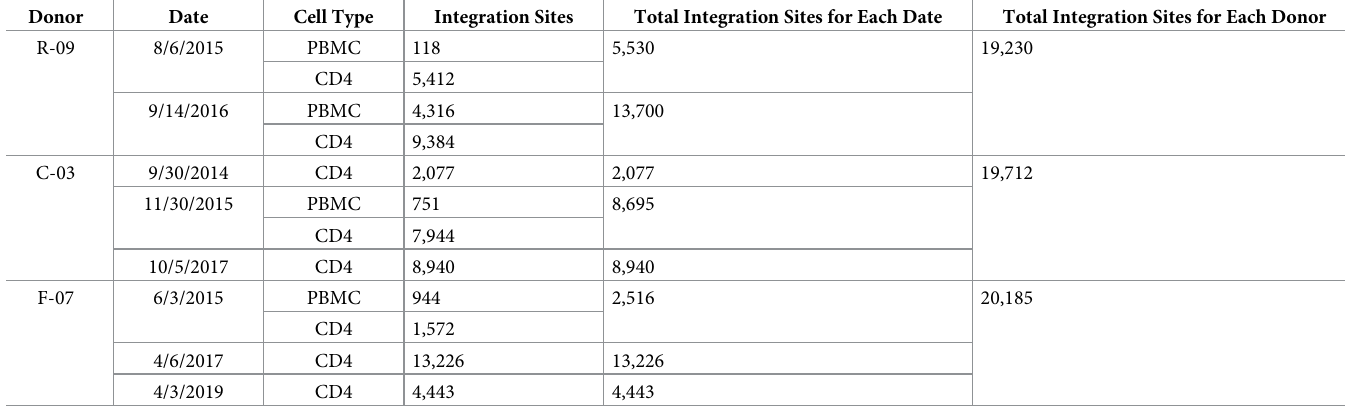
Table 2. Integration Sites Obtained from the Three Donors.